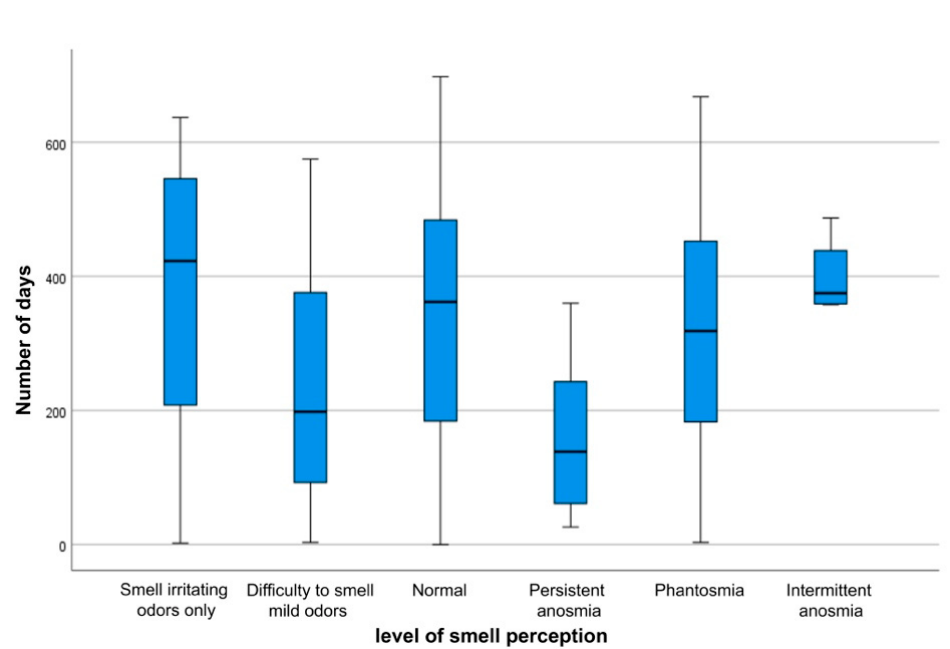
Figure 3. Boxplot of the number of days for each stage of loss of smell.